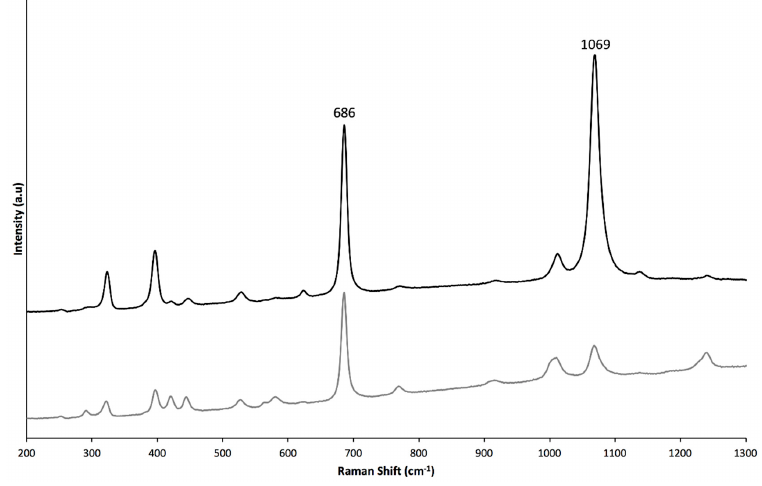
Figure 21. Raman spectra from 200 to 1300 cm − 1 of an emerald from Colombia. The black and grey spectra are acquired with the laser beam perpendicular to the c-axis and parallel to the c-axis, respectively. The upper spectrum has been vertically offset for clarity.